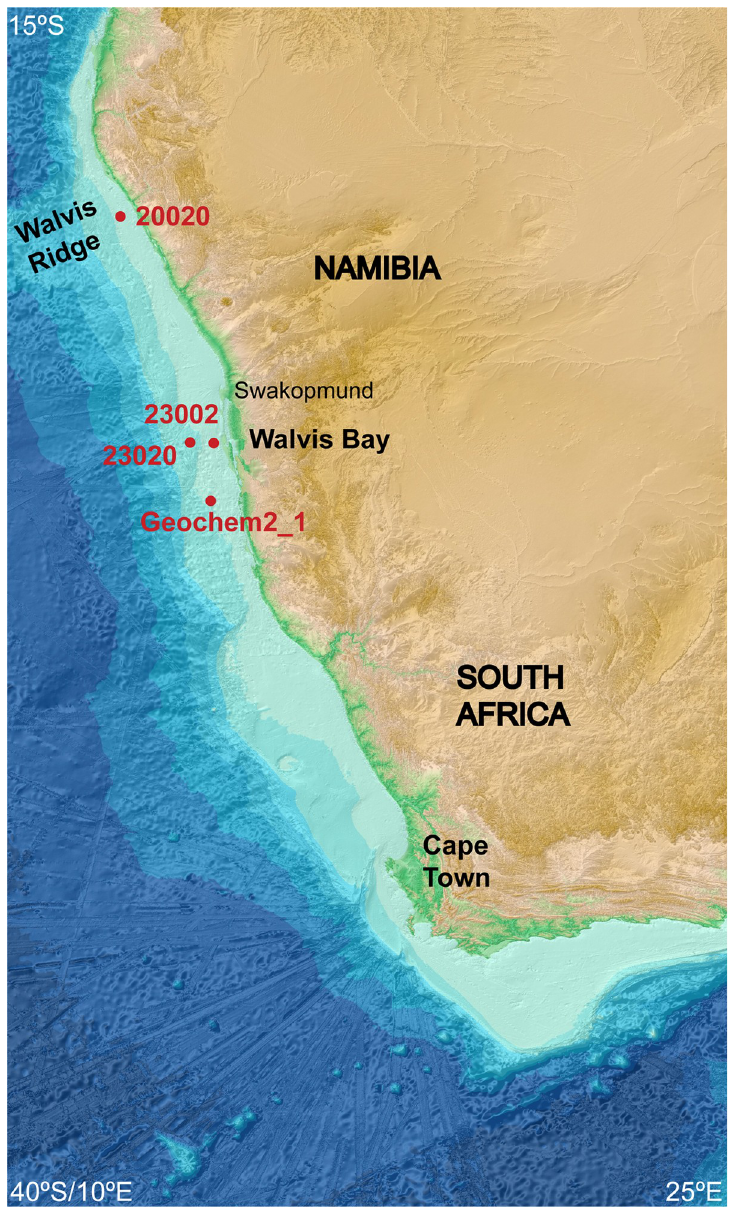
Fig 2. Map of sampling stations off the coast of Namibia, Africa. The sampling sites in this study were Marine Station 23002 (-22.999967, 14.3708), depth 36.4 m; Station 23020 (-23.00125, 14.04775), depth 125 m; Station 20020 (-20.002283, 12.67975), depth 85.8 m; and Station Geochem2_1 (-24.050,733, 14.250233), depth 118 m. The baseline map was reproduced from the GEBCO world map 2021, www.gebco.net. profiles of the water columns (S1 Fig) and microprofiling of the bottom water above the cores indicate that all stations were either hypoxic or anoxic. Stations 23002 and 23020 are the closest stations to one another along the -23 latitude axis but geochemical profiles, Fig 3, and Principal Coordinate Analysis, Fig 4, as well as hierarchical clustering via Euclidean distance matrix (S2 Fig) indicate that the two sampling stations at deeper water depths were more similar to one another, while the other sites were distinctly different. Measures of richness, Chao1 and